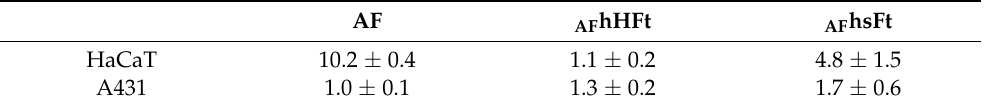
Table 2. IC 50 values expressed as gold concentration ( μ M) after 48 h of incubation with AF, AF hsFt and AF hHFt (based on the concentration of AF obtained via ICP-AES) on HaCaT and A431 cell lines.